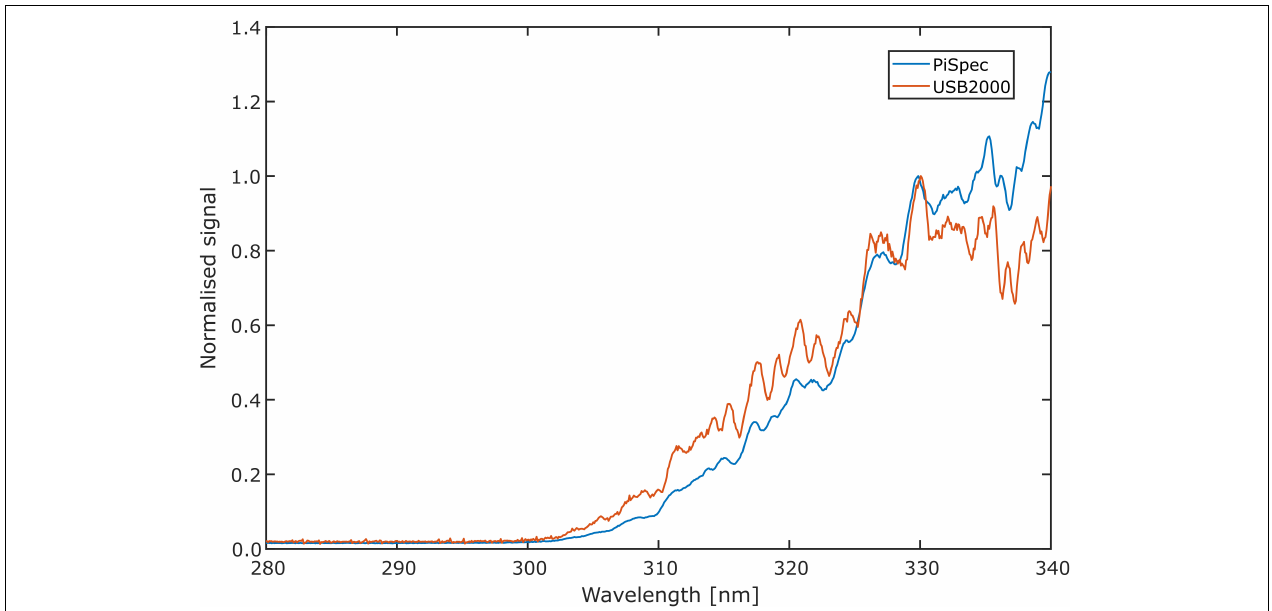
FIGURE 2 | Clear sky spectra gathered by the PiSpec and USB2000. Both spectra have been dar-subtracted and then normalized to the peak at ≈ 330 nm. This peak was at 48 and 52% saturation for the PiSpec and USB2000,